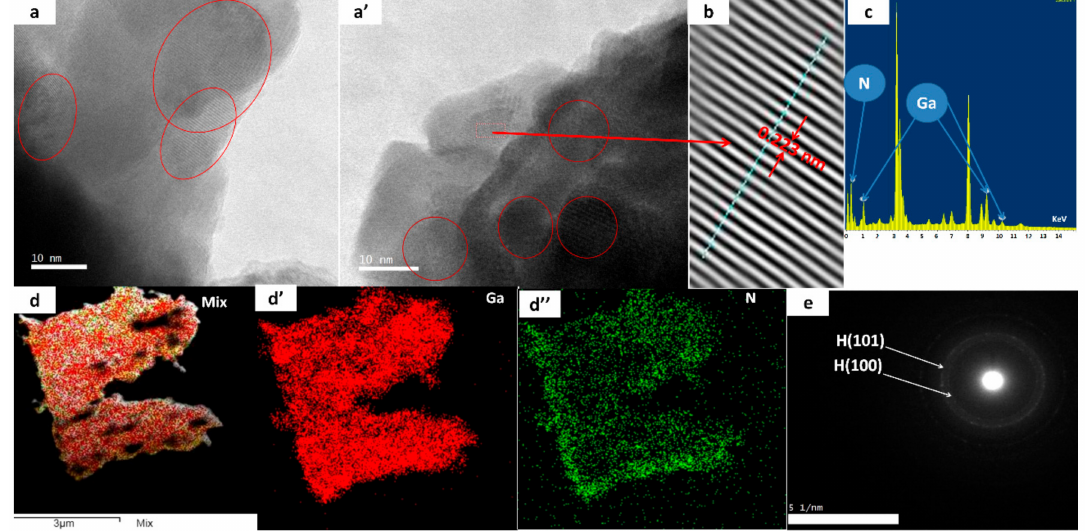
Figure 4. TEM and HRTEM of GaN; ( a , a’ ) thin film, ( b , b’ ) d-spacing, ( c ) EDAX spectrum, ( d , d’ , d” ) Ga and N mapping, and ( e ) SAED